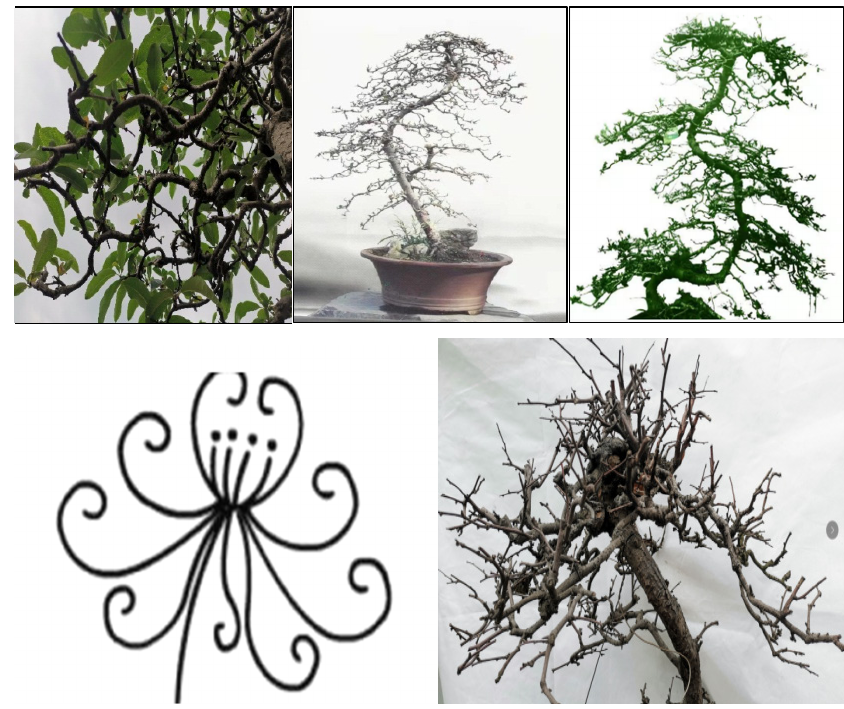
Figure 10. Styling features of the semiflat/semirolled branches.